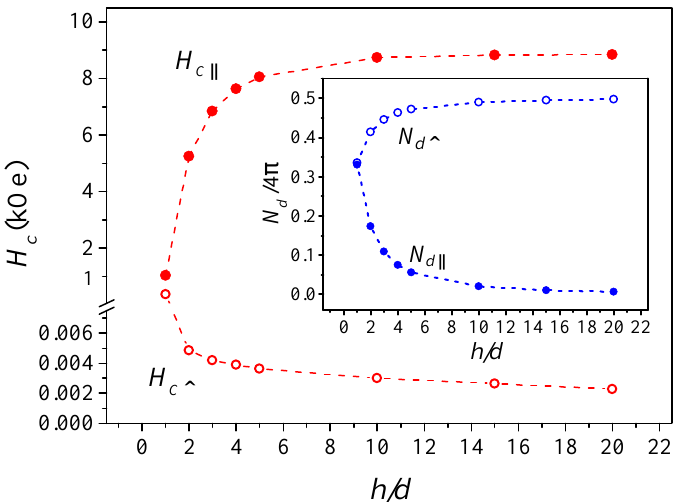
Figure 3. Coercive field for cylindrical nanostructures for the parallel and perpendicular orientation of the magnetic field as a function of the aspect ratio (inset: dependence of demagnetization factor values on the aspect ratio).